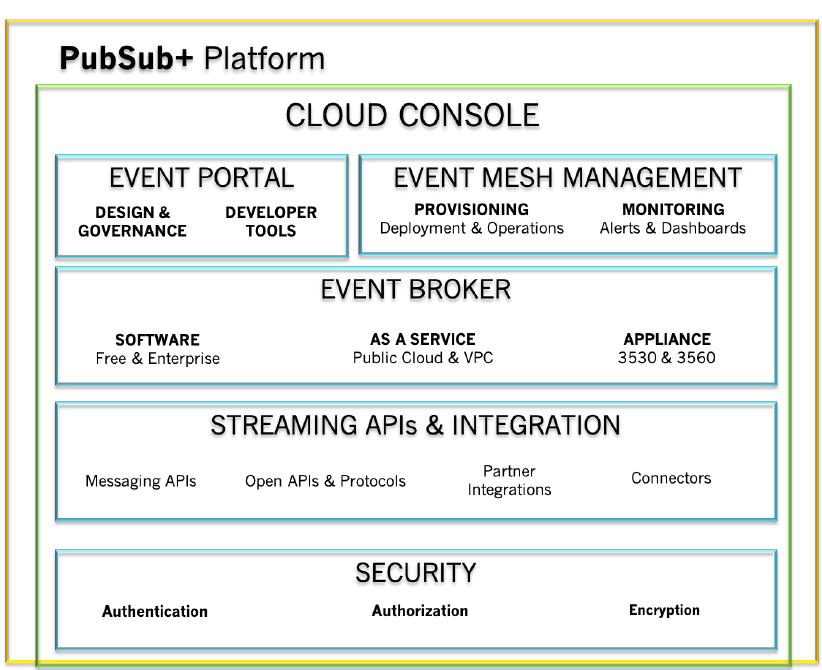
Figure 3. Layout of the internal layers of PubSub+. Adapted from Reference